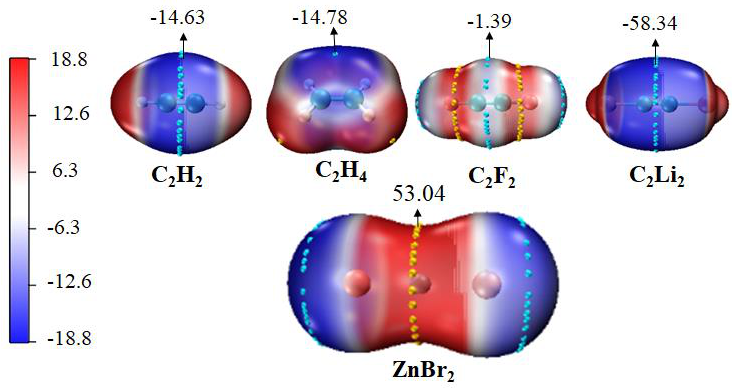
Figure 1. MEP surfaces of ZnBr 2 and π systems at the MP2/aug-cc-pVTZ(PP) level of theory at the 0.001 electrons Bohr – 3 . Cyan and yellow balls on the surface correspond to V min and V max , respectively. All are in kcal/mol. Table 1. The most positive ( V max ) and negative ( V min ) MEPs on the M atoms and π systems. All in kcal/mol.